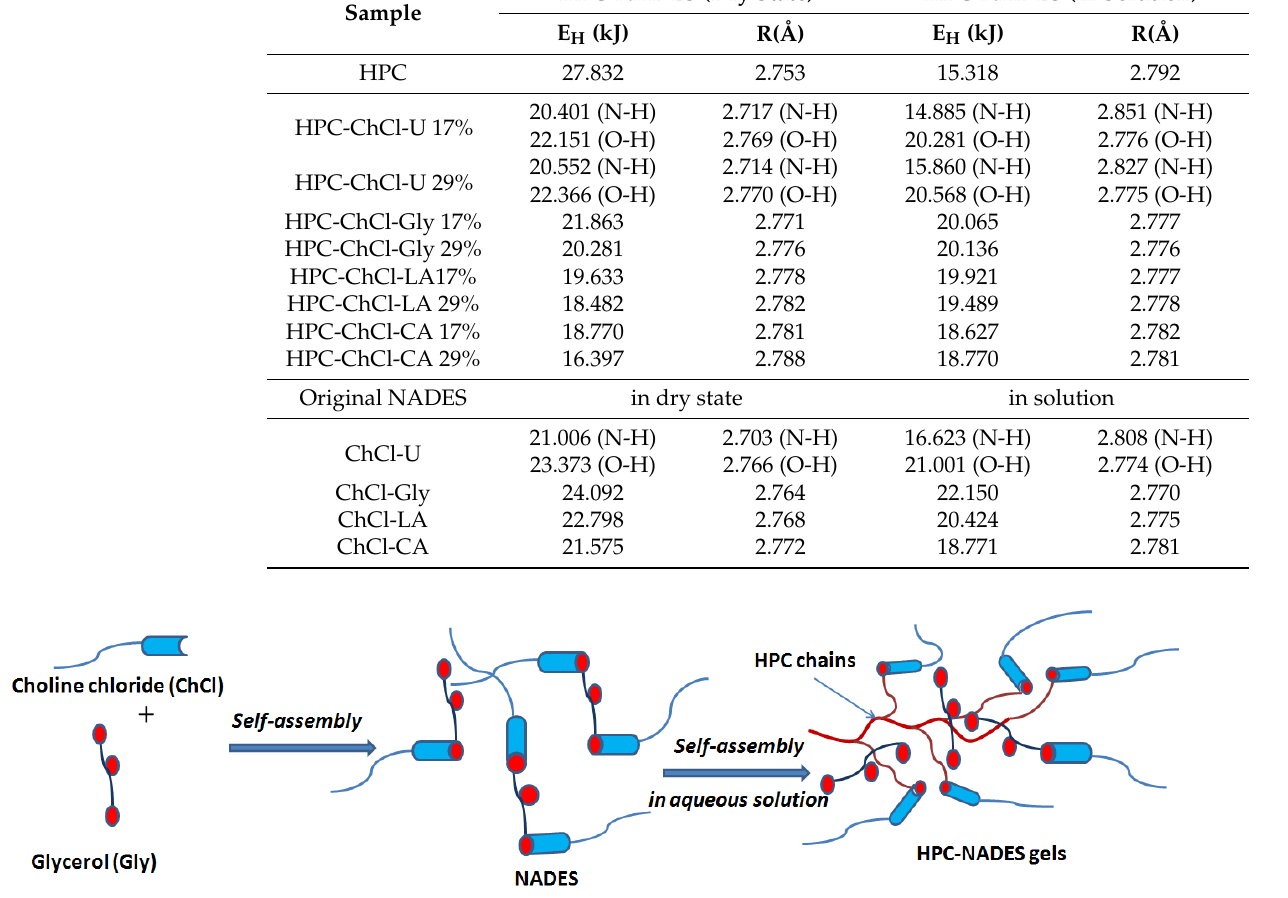
Table 1. The energy and the distance of hydrogen bonds in NADES and HPC-NADES samples. HPC-NADES (Dry State) HPC-NADES (in Sample